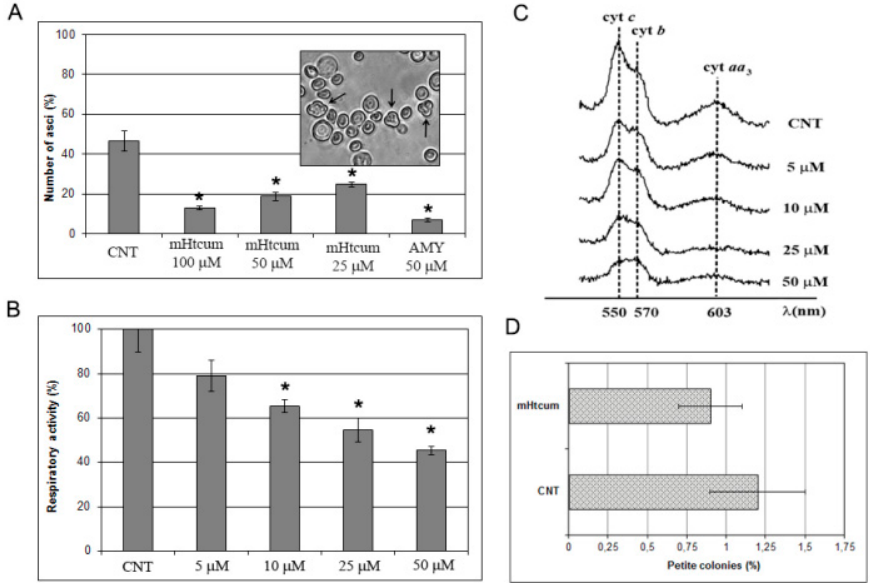
Figure 3. Interference of mHtcum on mitochondrial activity in S. cerevisiae . ( A ) Asci production in